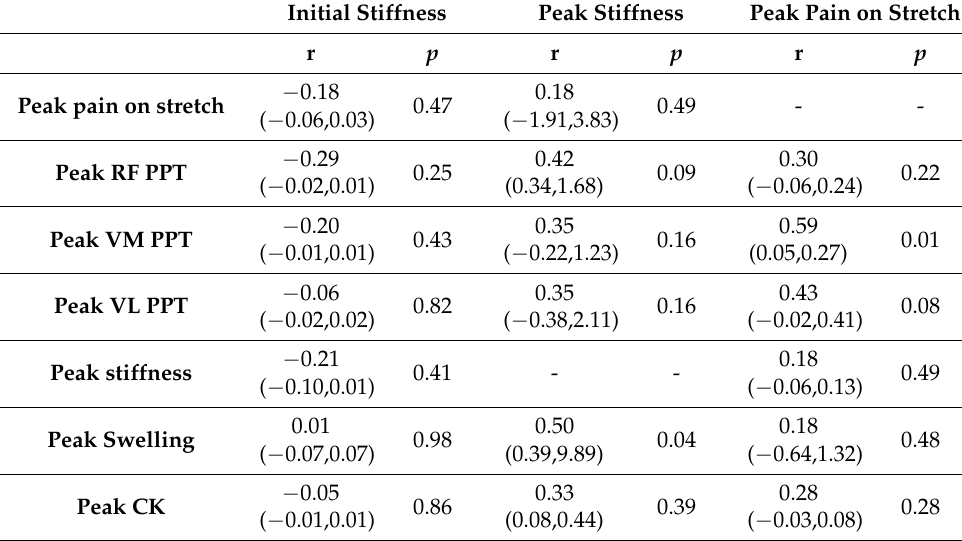
Table 1. Correlations between stiffness and peak pain in response to stretching with peak pain to pressure, swelling, and plasma CK activity ( n =